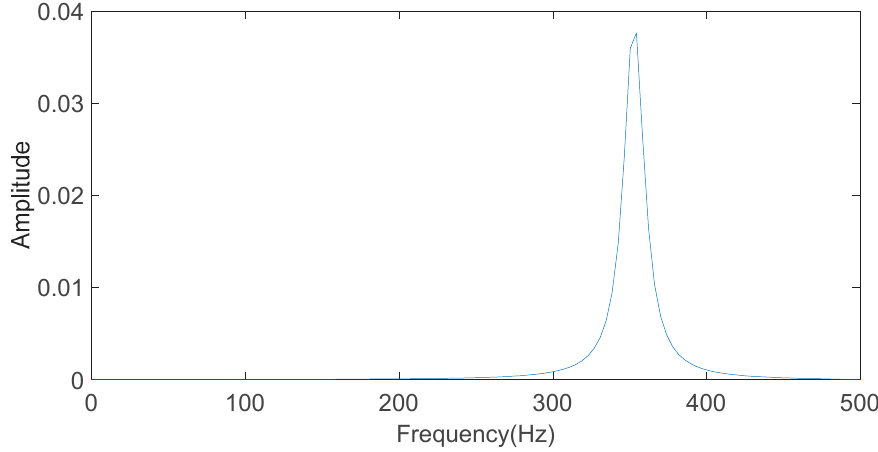
Figure 1. Time-domain waveform of the simulation component signal